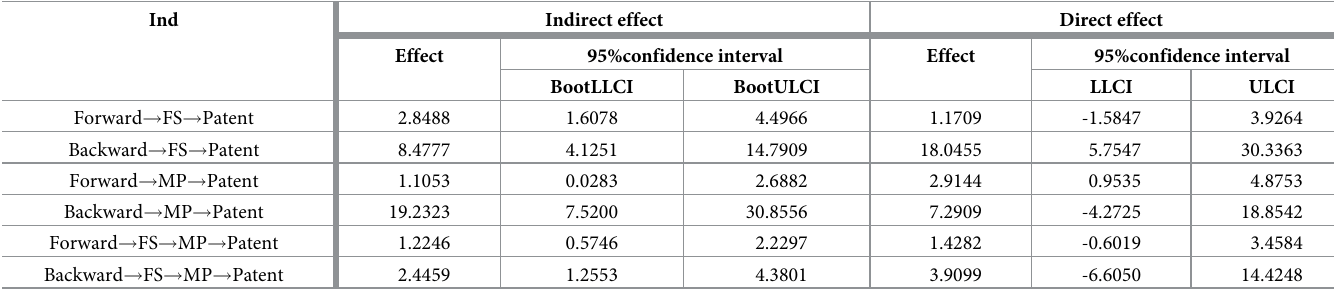
Table 8. Enterprises with high marketization process.